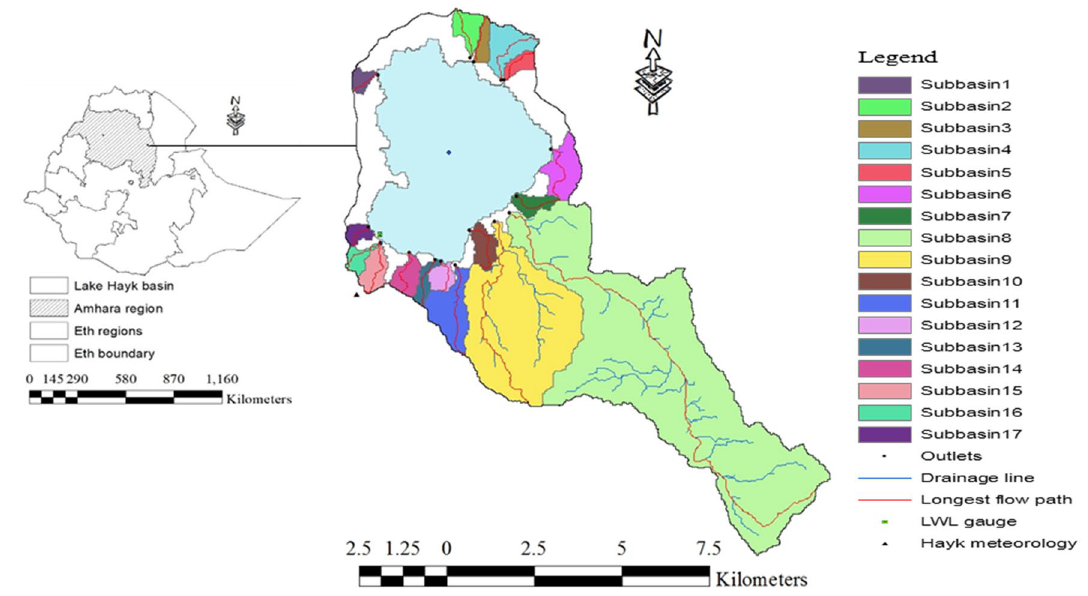
Fig. 1 Map showing location and subbasins of Hayk Lake basin. (The subbasins and their associated stream networks for each outlet point were delineated in batch following terrain preprocessing of the DEM using Arc